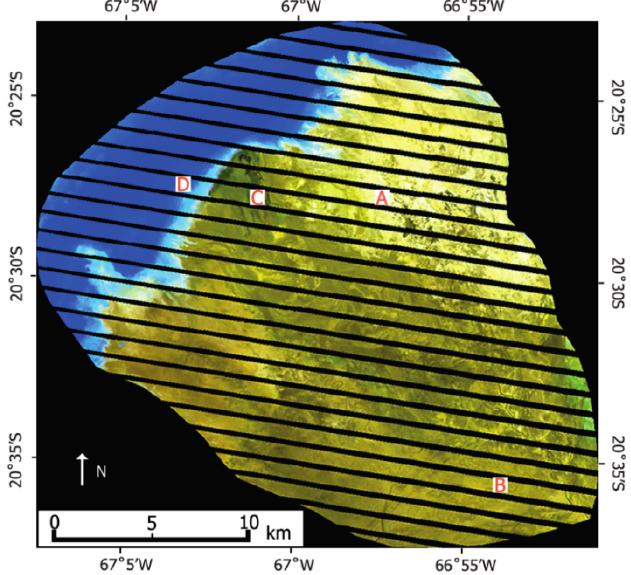
Figure 4. False-color composite of bands 7 (red), 5 (green) and 1 (blue) of Landsat ETM+ on 11 November 2012. A, B, C and D represent different surface materials. The black strips are caused by the failure of the Scan Line Corrector (SLC) of Landsat 7.